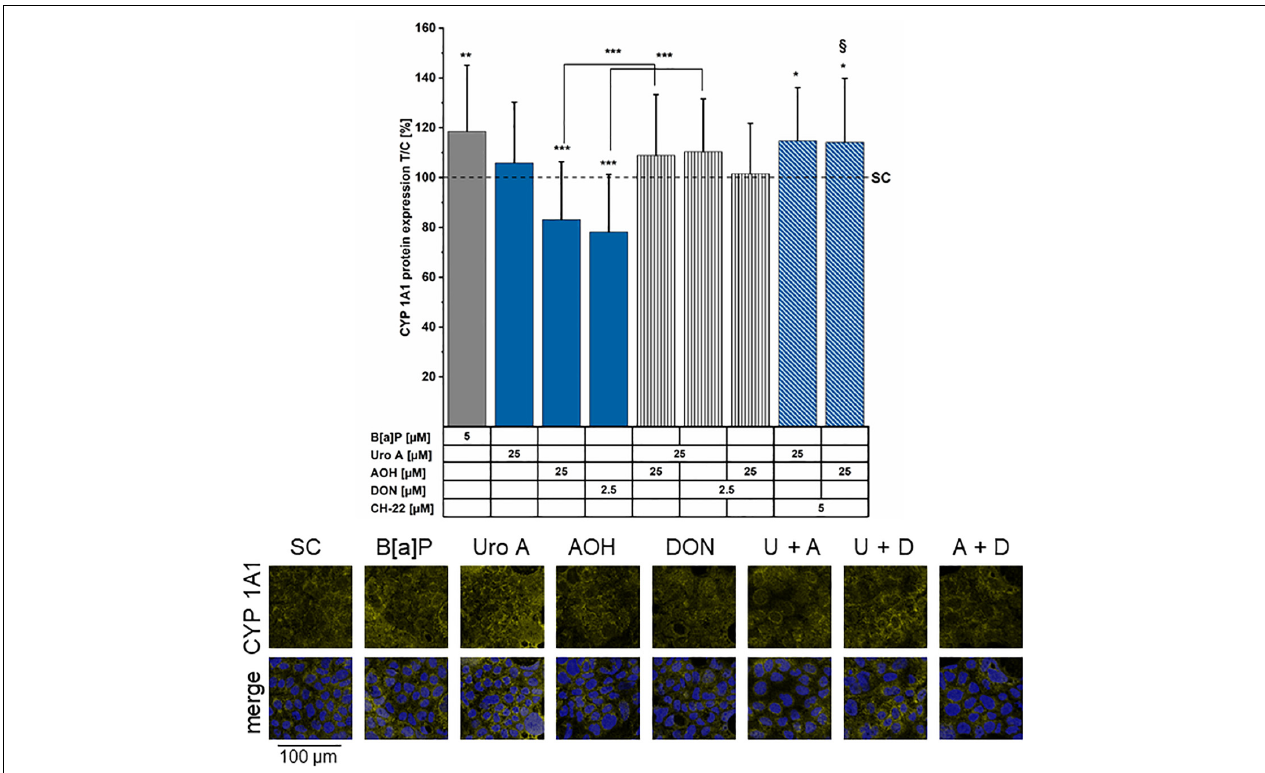
FIGURE 8 | Immunofluorescence staining of CYP1A1 protein. CYP1A1 was stained after 48 h of incubation period (minimum four biological replicates). Fluorescence intensities were normalized to the solvent control (SC) and are presented as test over control (T/C) in percent. Significant differences compared to the SC were calculated by applying two-samples Students’ t -test and are shown as * p < 0.05, ** p < 0.01, and *** p < 0.001. § p < 0.01 marks differences of combinatory incubations with CH-22 compared to the respective second compound. Panel of immunofluorescence images showing CYP1A1 protein localization (yellow) in the following conditions: SC, B[a]P 5 µ M, Uro A 25 µ M, AOH 25 µ M, and DON 2.5 µ M. Merge shows CYP1A1 (yellow) and nuclei (blue) together. In the example images the abbreviations U for Uro A, A for AOH, and D for DON are used for the